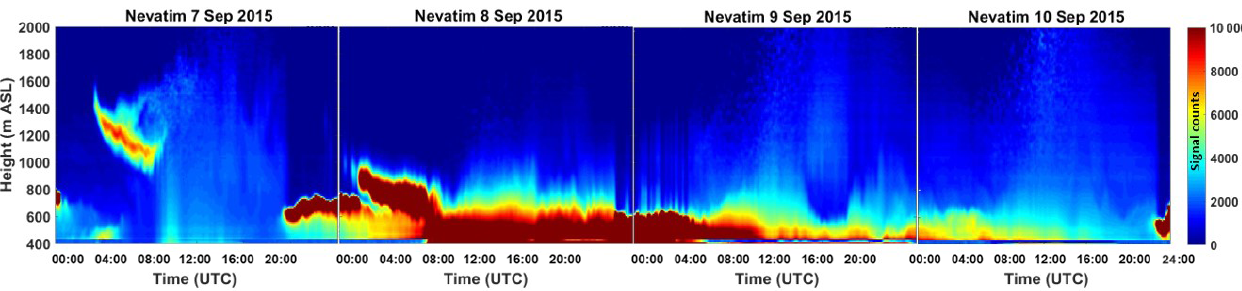
Figure 11. Nevatim ceilometer signal counts plots for 7–10 September 2015. The y axis is the height from site deployment to 2000ma.s.l., the x axis is the time in UTC, and the signal count scale ranges between 0 and